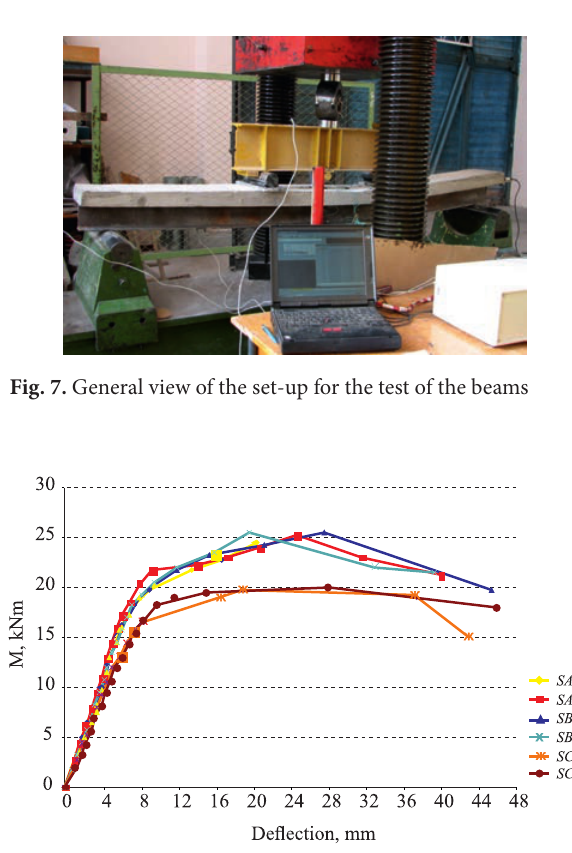
Fig. 8. Experimental deflections of the composite beams